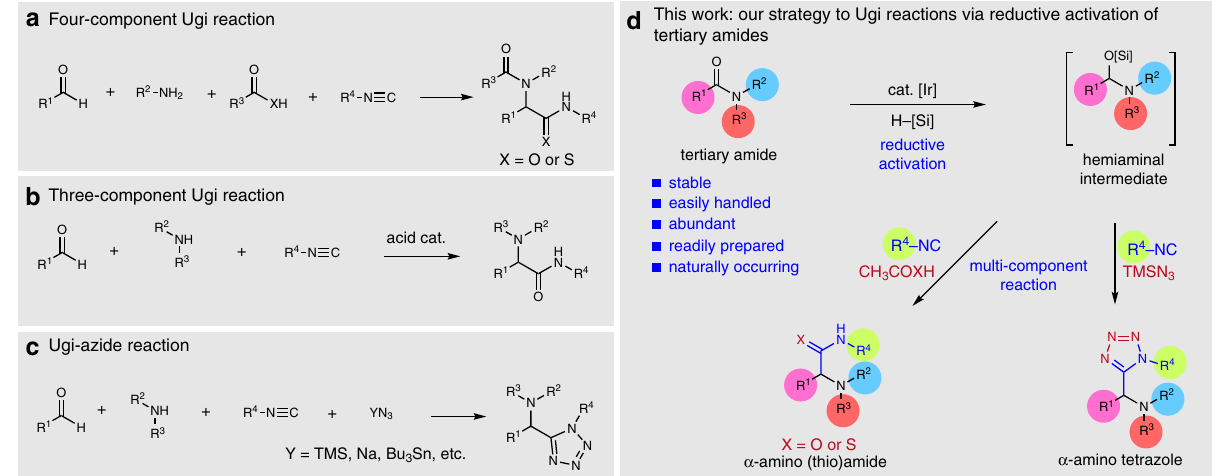
Fig. 1 Proposed reductive Ugi-type reactions of tertiary amides. a Classical four-, b three-component Ugi reactions, and c Ugi-azide reaction, d our proposed reductive Ugi-type reactions of tertiary